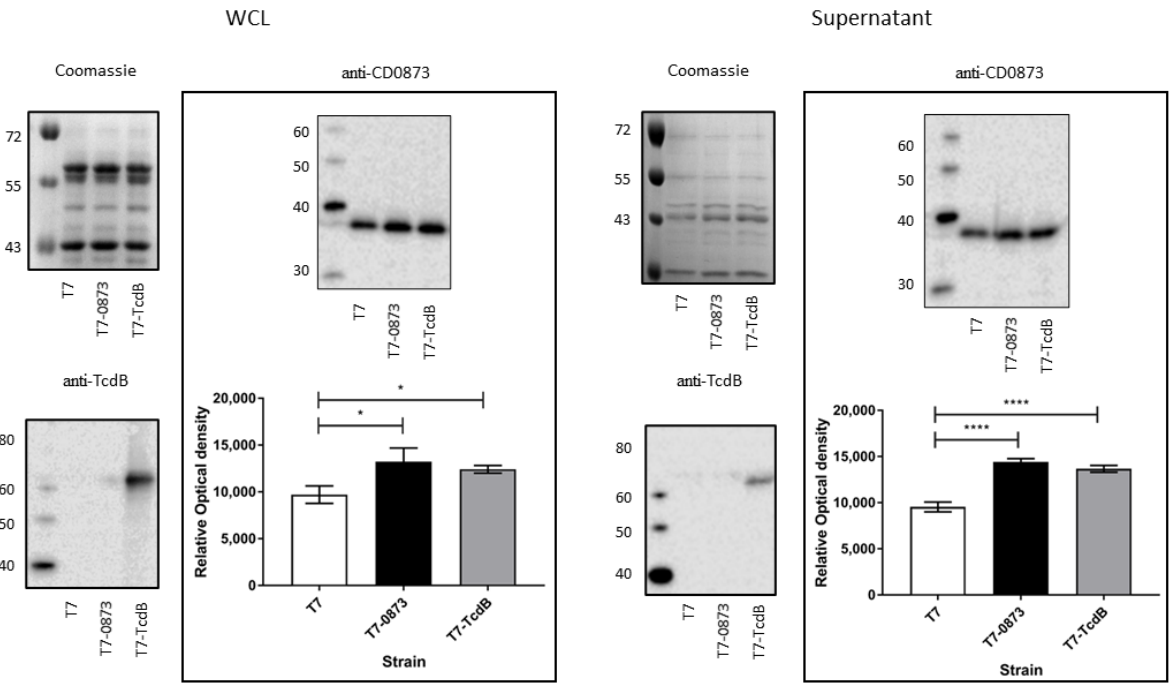
Figure 3. Detection of the expression of antigens in recombinant strains of T7 by SDS-PAGE (10% acrylamide) and Western immunoblotting. Whole cell lysates (WCL) and supernatants of strains T7, T7-0873 and T7-TcdB were harvested from BHIS broth cultures at early stationary phase, A 600 nm 1.0. Replica gels for both WCLs and supernatants were stained by Coomassie Blue to confirm equal loading of samples. Western immunoblots with anti-TcdB antibody detected TcdB-RBD mainly intracellularly in T7-TcdB. Western immunoblots with anti-CD0873 antibody detected CD0873 in WCLs and supernatants of all strains with significantly enhanced levels in both recombinant strains. Bands were detected by the addition of the appropriate HRP-conjugated secondary antibody and ECL Western Blotting Detection Reagent. Densitometry was carried out in ImageJ. Error bars represent the standard deviation (SD). Data were analysed by a one-way ANOVA with Dunnett’s multiple comparison. Statistical difference p values: * p < 0.05, **** p <